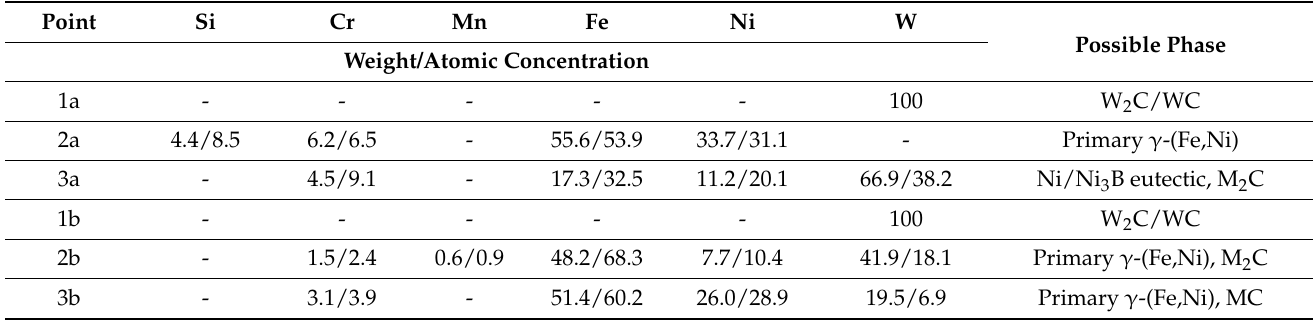
Figure 11. Scheme of hardness measurements on the cross ‐ section of a single stringer bead, Figure 12.